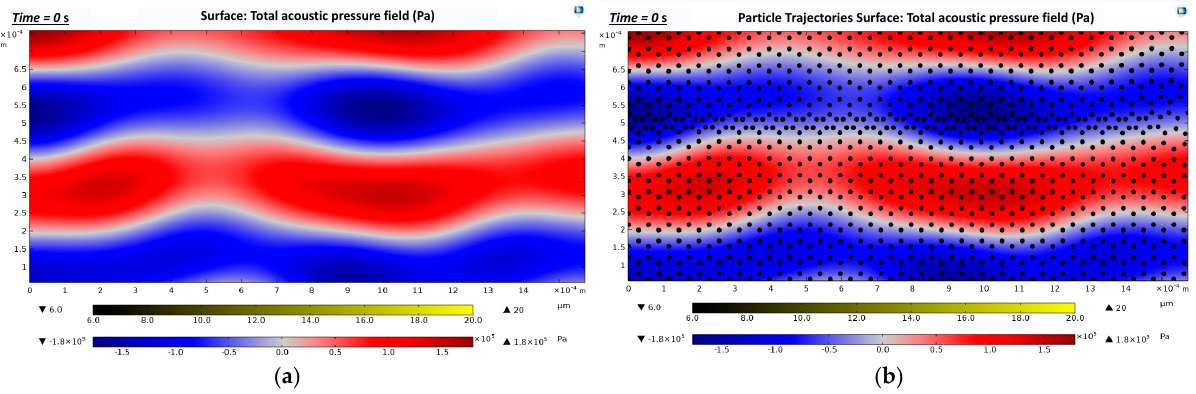
Figure 7. Total acoustic pressure field (zoom-in images that show three pressure nodal lines occurring in the straight rectangular section): ( a ) Formation of an acoustic pressure field along the straight rectangular section of the microchannel. The blue and red areas represent the pressure antinodal lines. The white areas represent the pressure nodal lines; ( b ) Cells trajectories at t = 0 s. The cells were set to zero initial